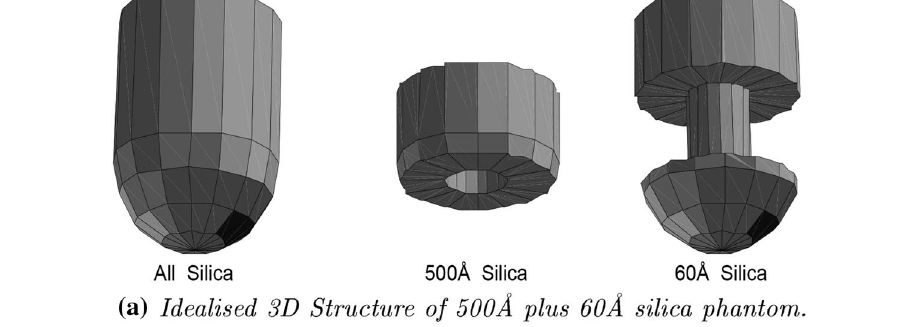
Fig. 28 3 D spatially resolved pore sizes—A structured sample prepared from 2 differ- ent sol-gel silicas, in a 10mm diameter test